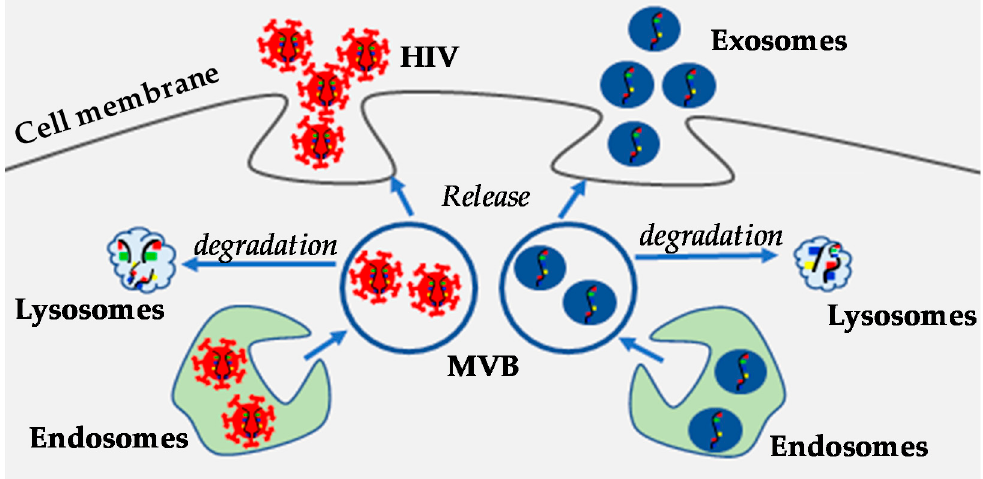
Figure 2. The exosome/microvesicle biogenesis pathway mediates HIV budding. HIV budding (red color) and exosome release (blue color) share similar pathways.